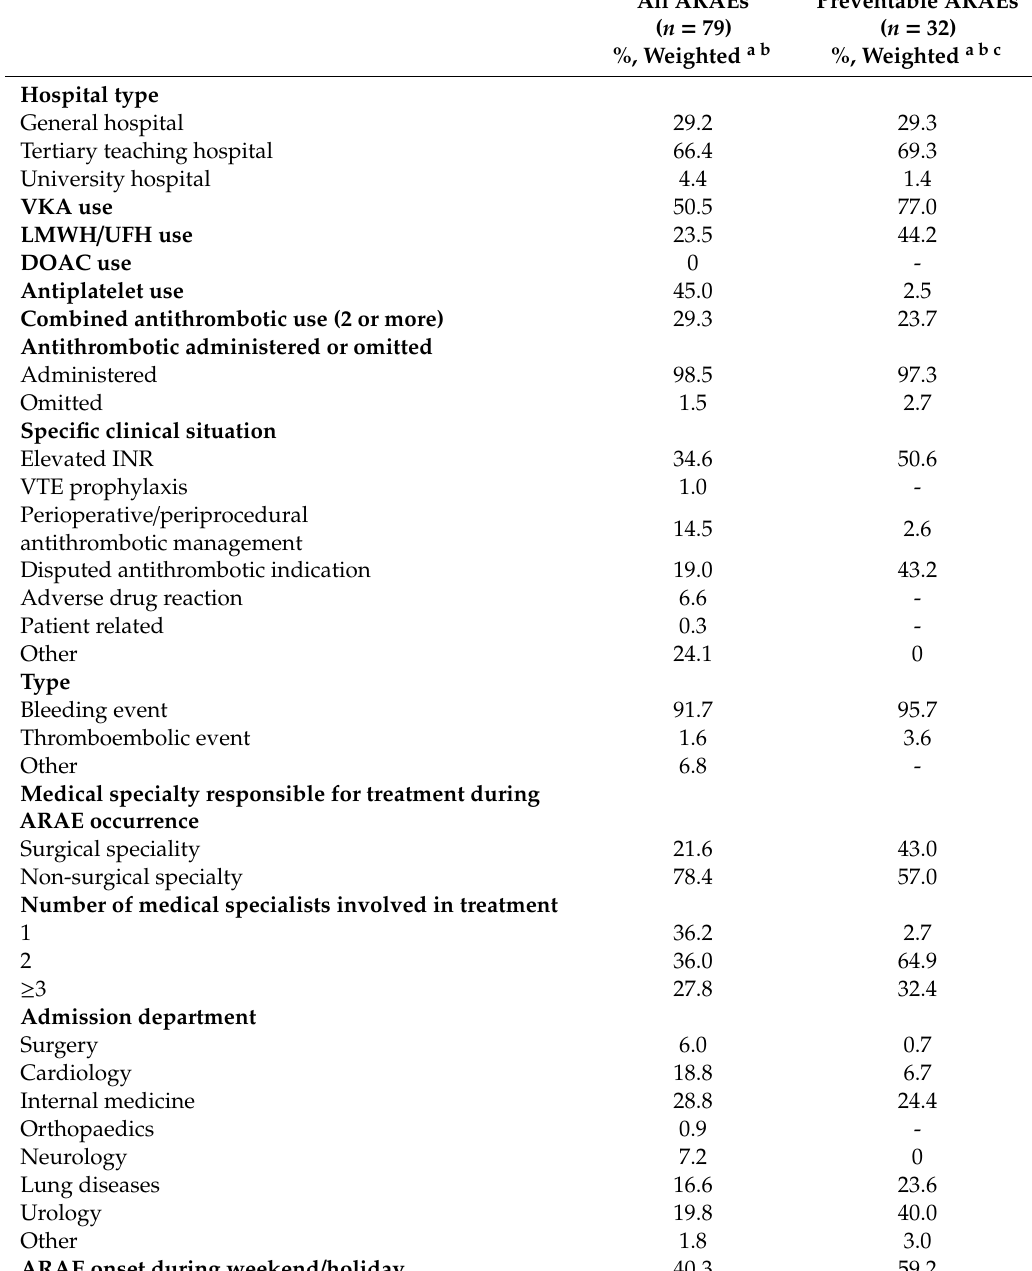
Table 3. Clinical context of (preventable) antithrombotic related adverse events between 2008 and 2015 /